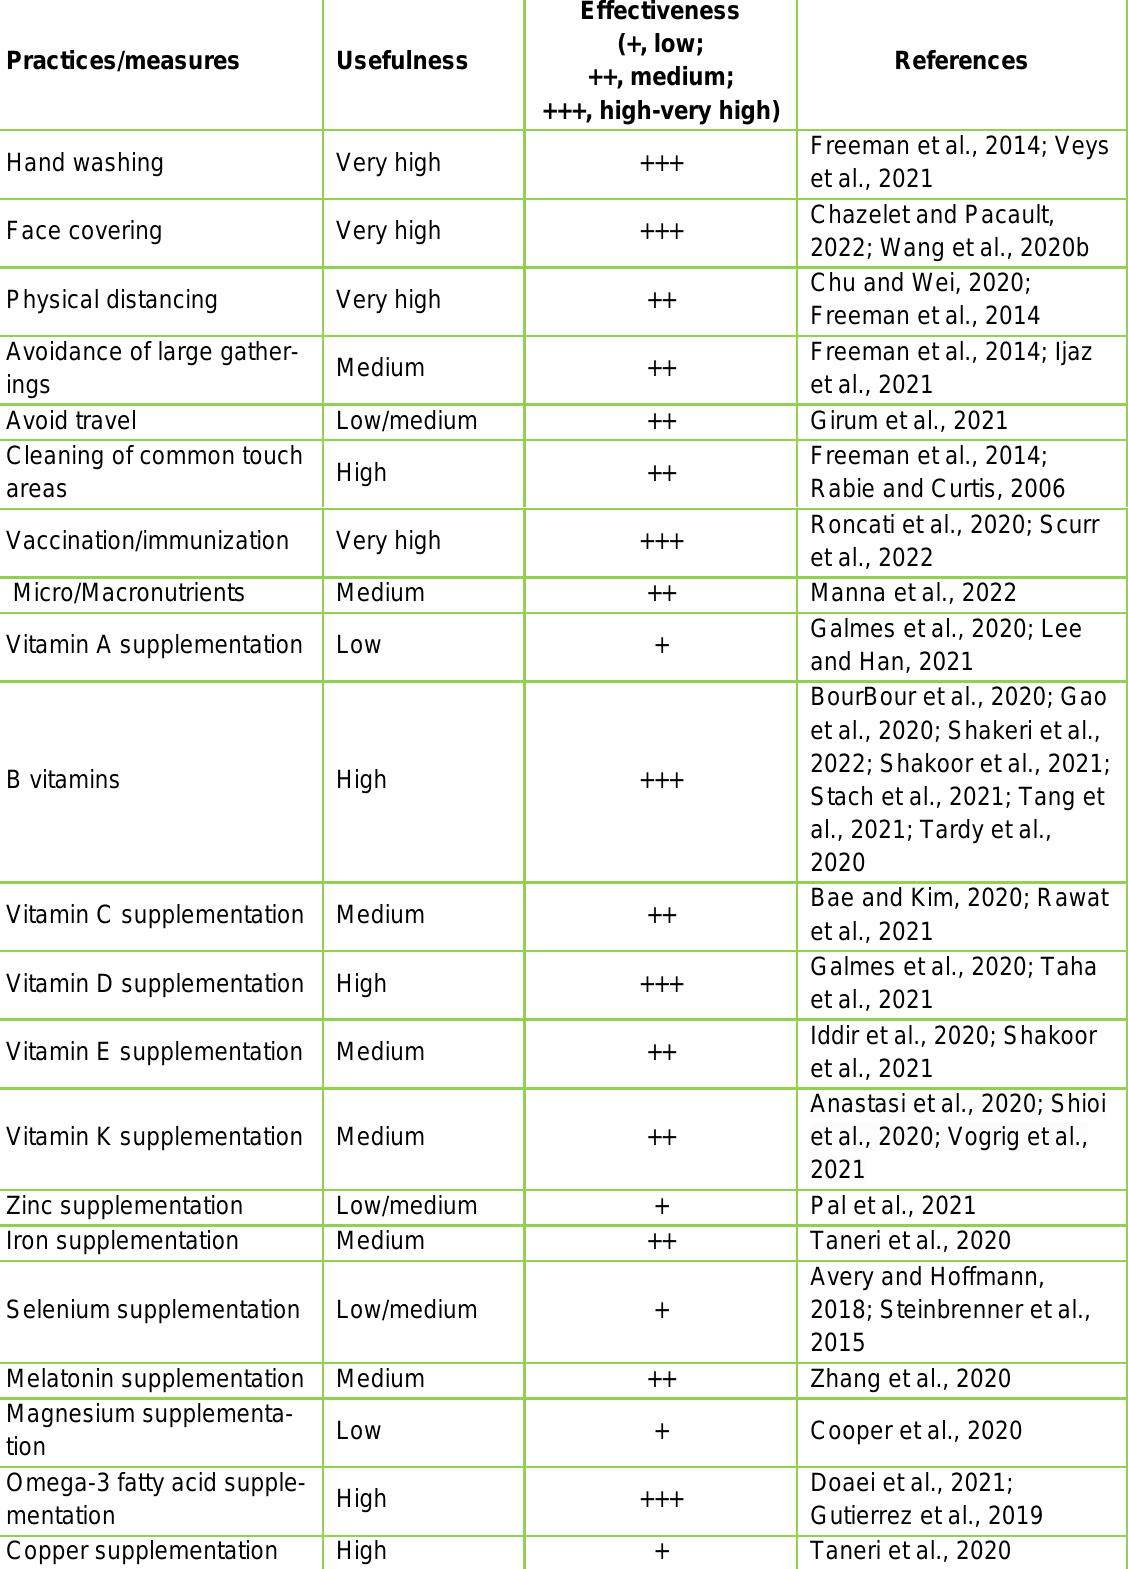
Table 2: Influence of a variety of practices and/or measures for the prevention of COVID-19 and its